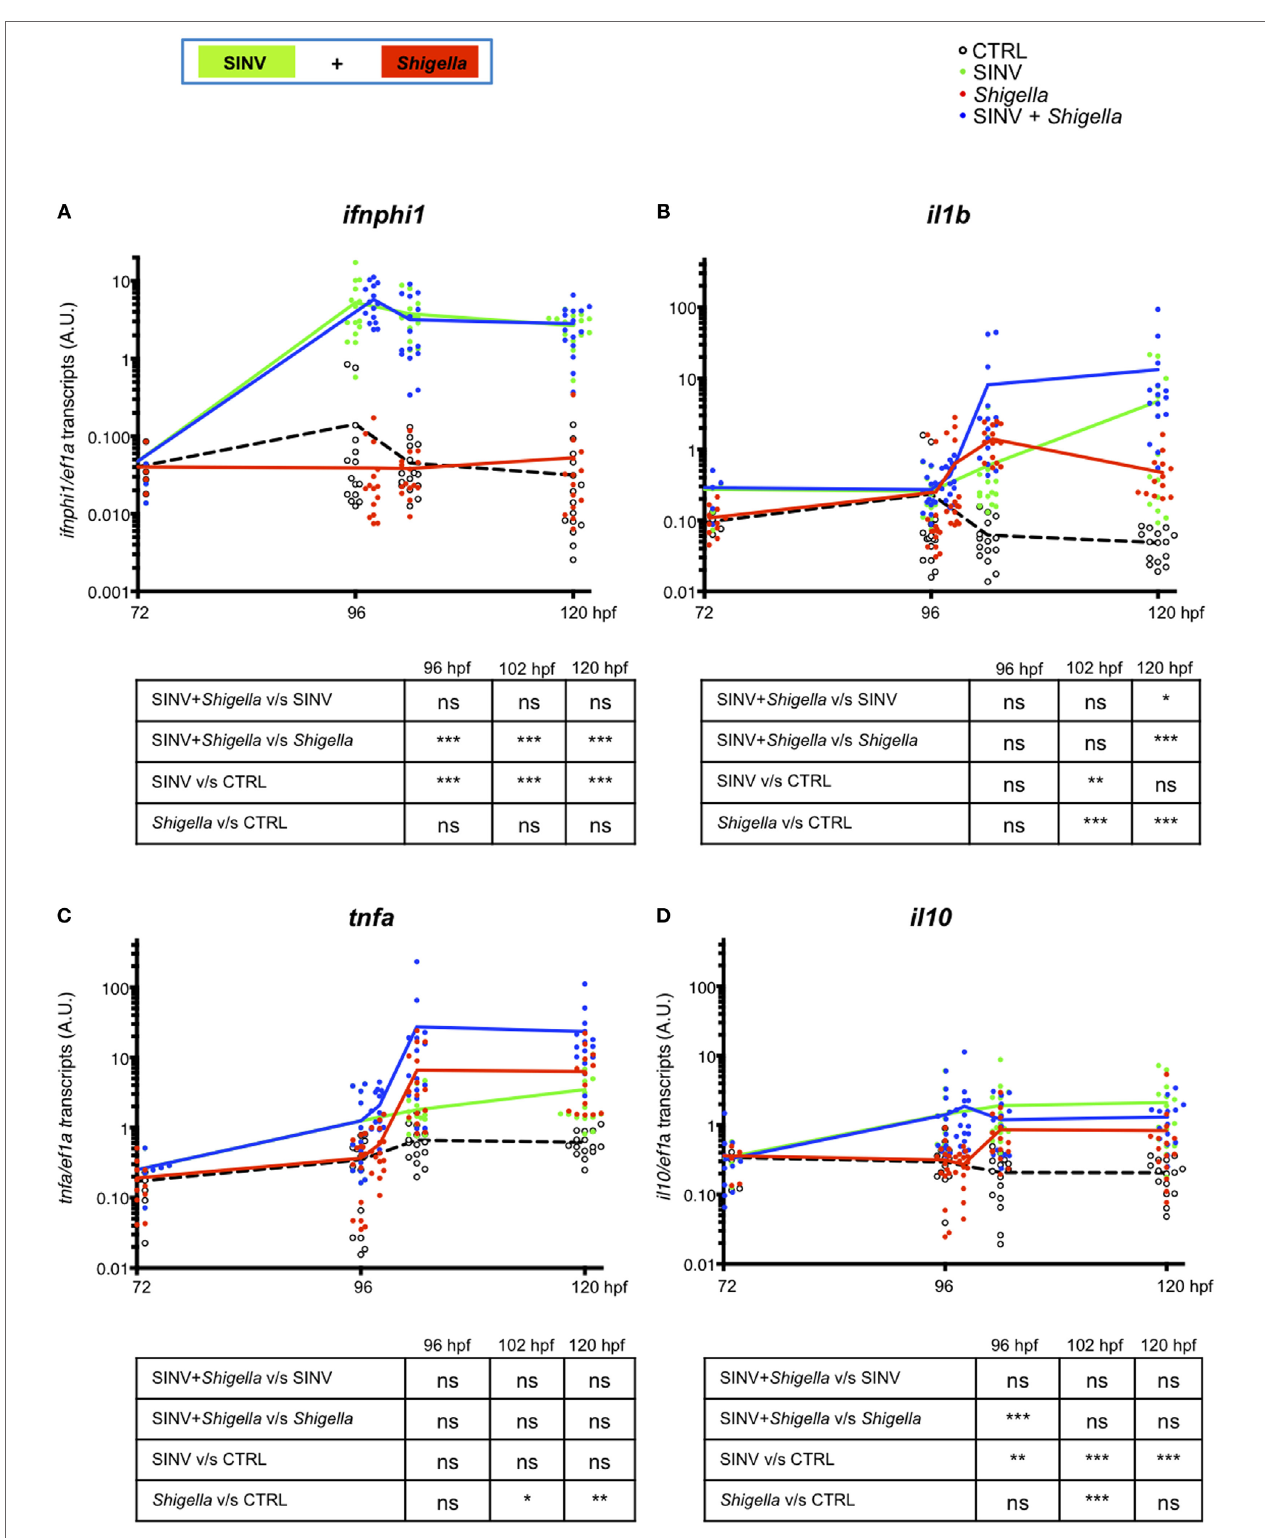
FigUre 5 | Cytokine gene modulation upon Sindbis virus (SINV) + Shigella co-infection. (a–D) Cytokine ( ifnphi1 , il1b , tnfa , il10 ) induction was measured from individual zebrafish larvae sequentially co-injected with SINV + Shigella (blue) or from individual zebrafish larvae injected with SINV alone (green) or with Shigella alone (red), and non-injected fish as control (CTRL, black curves). Data plotted are from three independent experiments pooled ( n = 15 larvae for each condition); individual values are shown and curves correspond to the means. Statistical analysis is shown as a table under each graph.